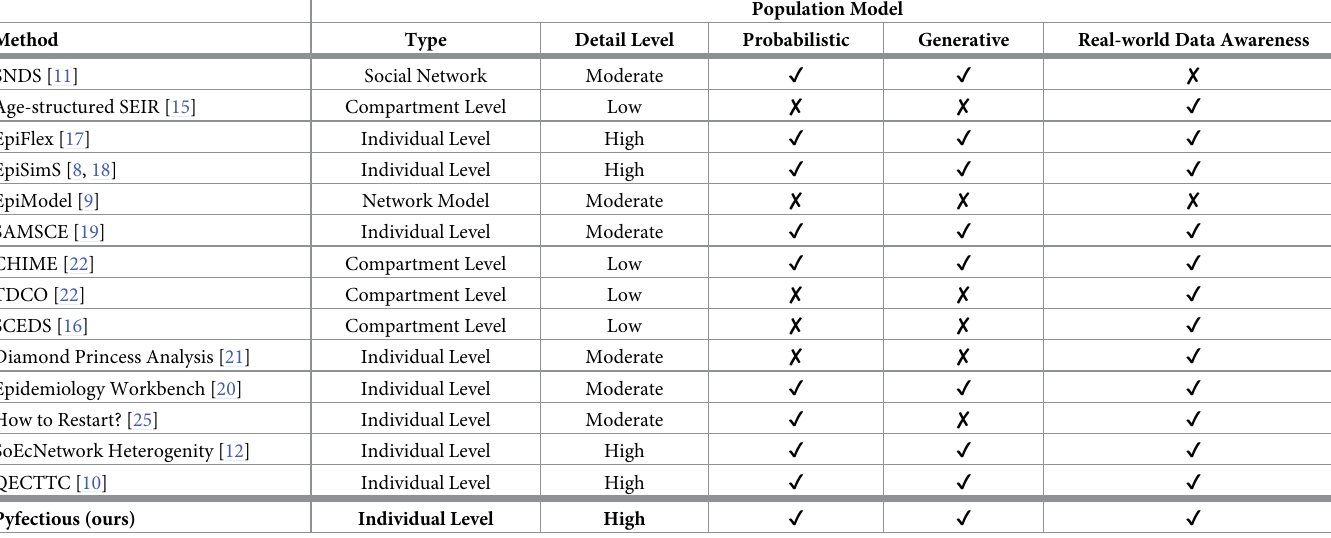
Table 1. Comparing the population model in various epidemic simulation